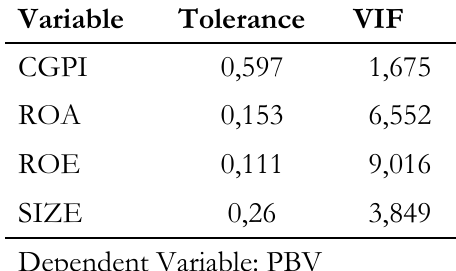
Table 4. Multicollinearity Test